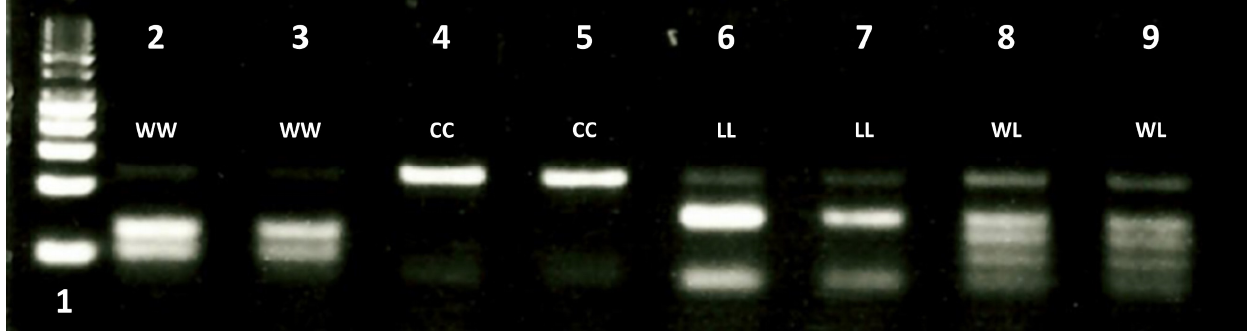
Figure 3. Characteristic dPACS profiles for wild and mutant 2027 ACCase alleles. Lane 1: 50 bp DNA ladder; lanes 2 and 3: wild type tryptophan allele (51/62 bp fragments), lanes 4 and 5: mutant cysteine alleles (unrestricted 113 bp fragment); lane 6 and 7: mutant leucine allele (37/76 bp fragments); lanes 8 and 9: heterozygous WL2027 (37/76 and 51/62 bp fragments).